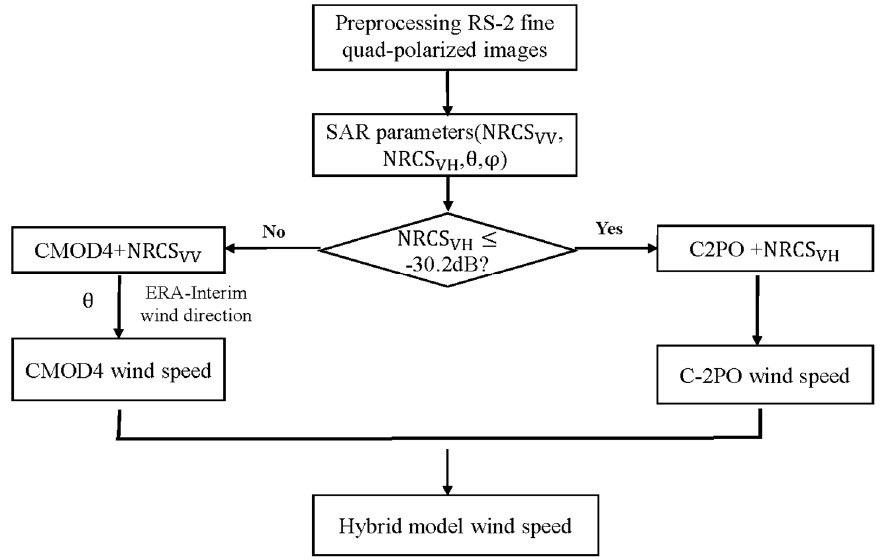
Figure 10. Flowchart for the hybrid wind speed retrieval algorithm.